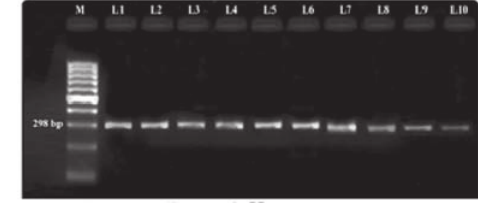
Fig. 2 Specificity of H. contortus primer Lane M: 100 bp ladder